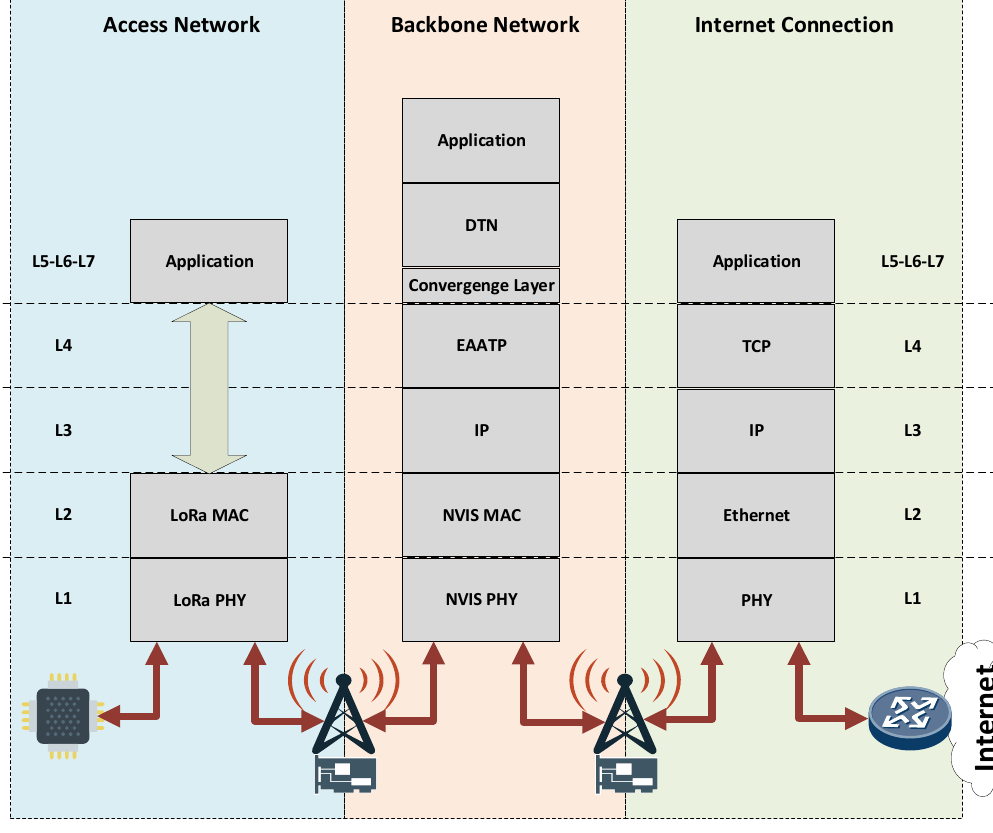
Figure 5. Antarctic IoT network protocol stack.